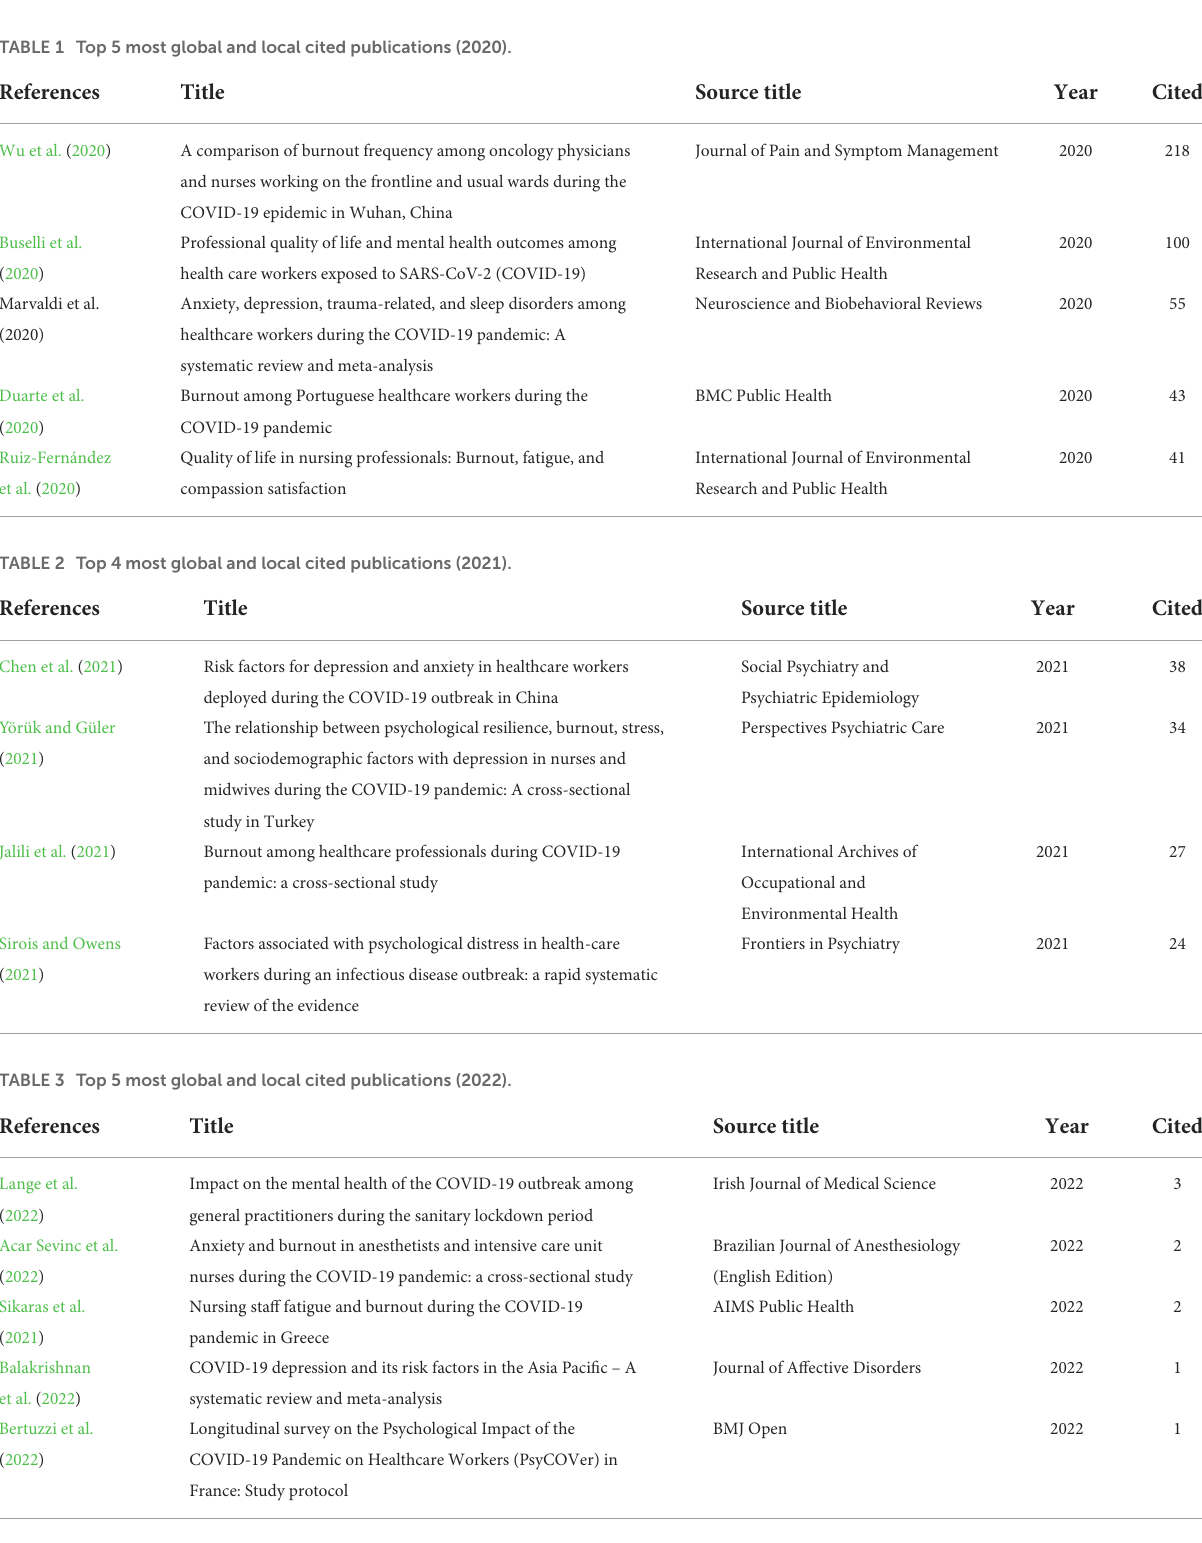
sample consisted of 332 general practitioners (43.50% women, mean age = 50.74 ± 11.91). General practitioners working in high epidemic areas represented 27.71% of the sample ( n =